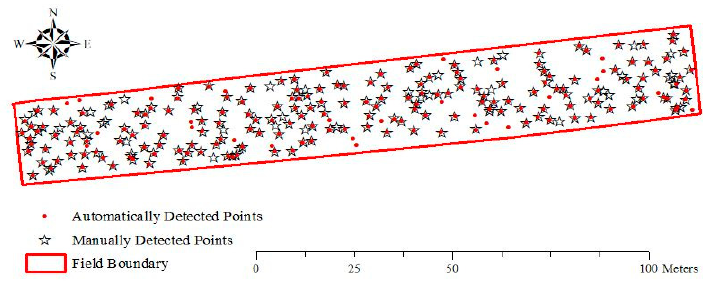
Figure 14. Field site II (powdery mildew disease detection map for site-specific management).